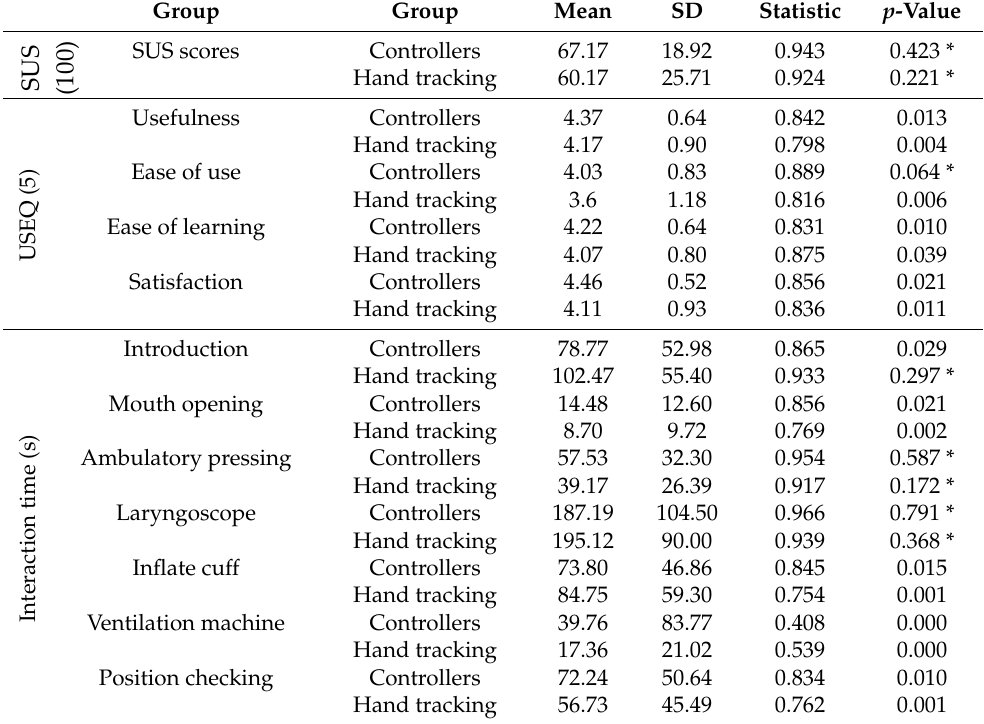
Table 4. Test of normality of SUS scores and USEQ scores of each criterion (* normal distribution p > 0.05).